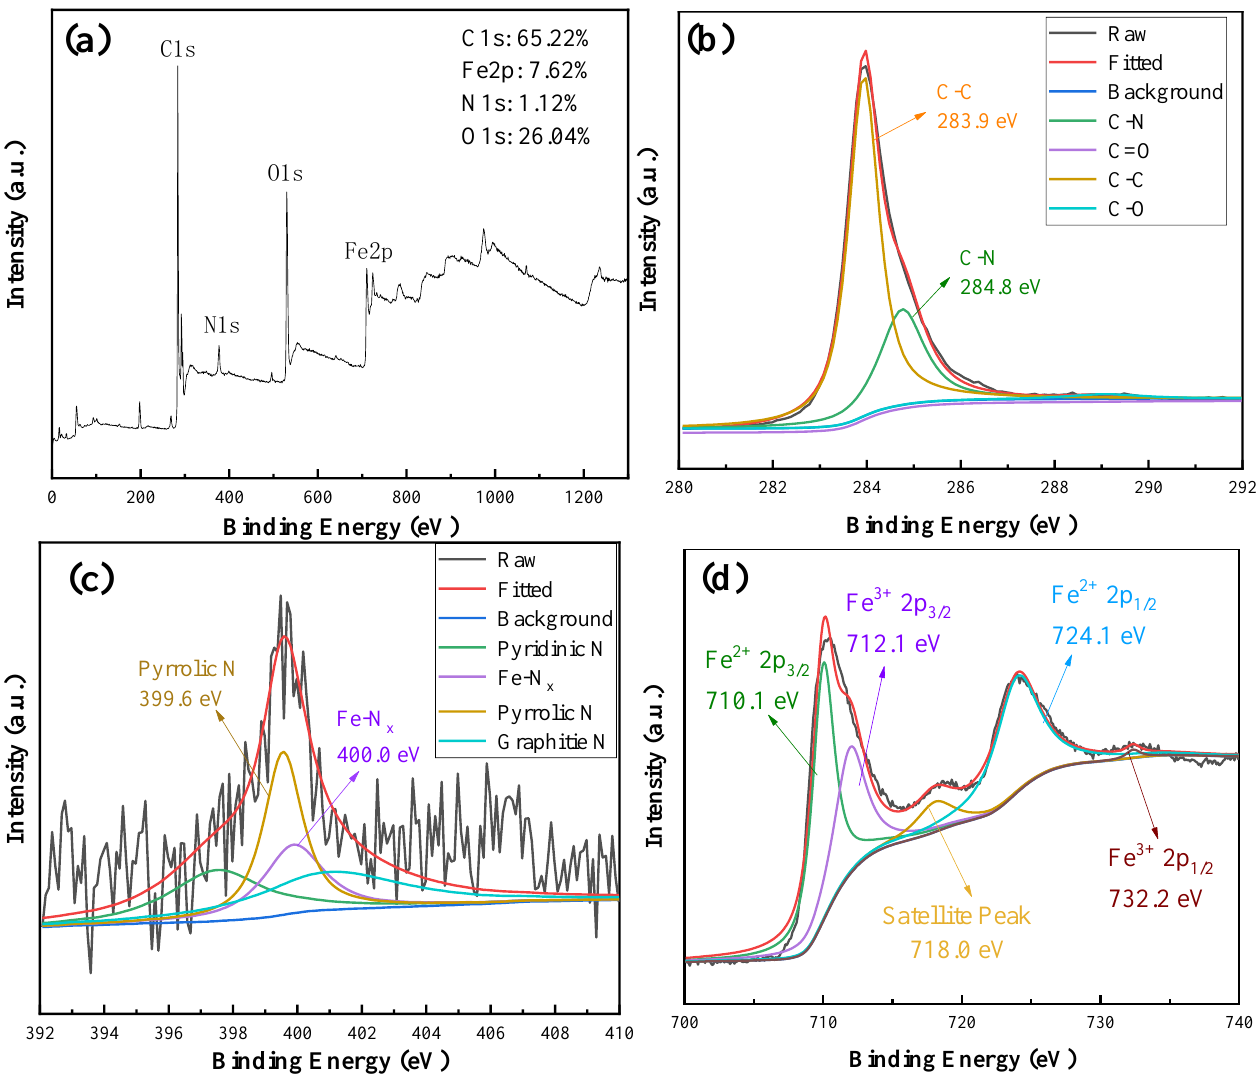
Figure 7. XPS spectra of 1 wt% Fe 3 O 4 /CNS composite film: ( a ) XPS survey of the samples, ( b ) the high-resolution C1s XPS spectra, ( c ) the high-resolution N1s XPS spectra, ( d ) the high-resolution Fe2p XPS spectra.